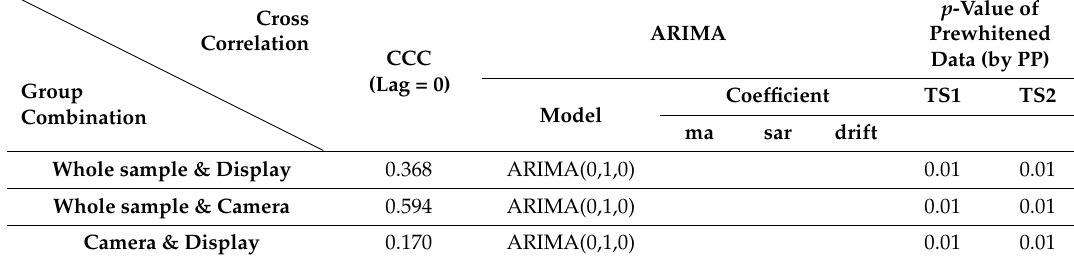
Figure 13. Average BHAR for 2010-2012. Table 5. Cross-correlation of average BHARs for Jan 2010-Dec 2012.